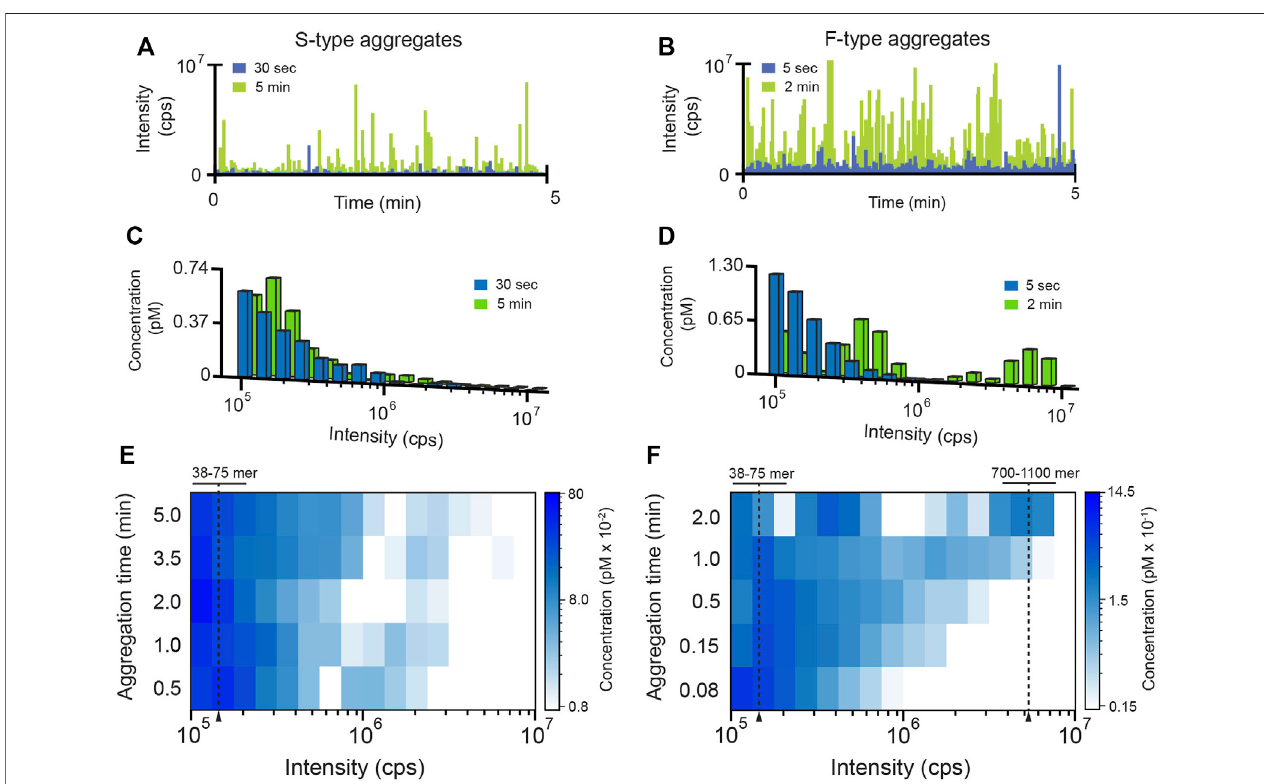
FIGURE 2 | Characterization of RuBisCO aggregation pathways at the single-particle level. The population-resolved kinetics of aggregate growth (200 nM RuBisCO monomer) was examined by BAS (Puchalla et al., 2008). At each time point, aliquots of an aggregating, tetramethylrhodamine-labeled RuBisCO (RuBisCO- TMR) sample were removed and diluted 20-fold (10 nM fi nal monomer) to halt aggregation and yield a total particle concentration appropriate for BAS. Raw photon histories were collected at early (blue) and late (green) aggregation time points for (A) S-type and (B) F-type aggregates. BAS was used to extract the underlying aggregate population distributions for the (C) S-type and (D) F-type aggregates. Time-dependent shifts in aggregate sub-populations were followed by sampling the aggregation reaction at higher time resolutions for (E) S-type and (F) F-type aggregates. For visualization purposes, high density BAS data is represented as a “ heat map, ” in which aggregate size is plotted on the x -axis, time or other variable is plotted on the y -axis, and the color of each bin is proportional to the concentration of particles at the given size. BAS histograms are a combination of n = 3 independent experimental replicates. Monomer number was established by calibrating the unitary brightness of the aggregate incorporated labeled monomer (see Supplementary Material ; Supplementary Figure S2